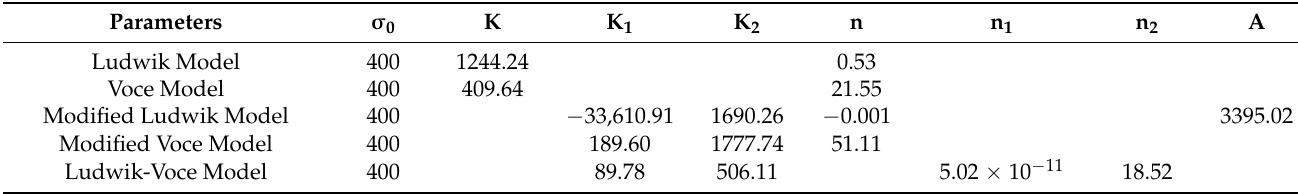
Table 4. Parameters of strain models in this paper.